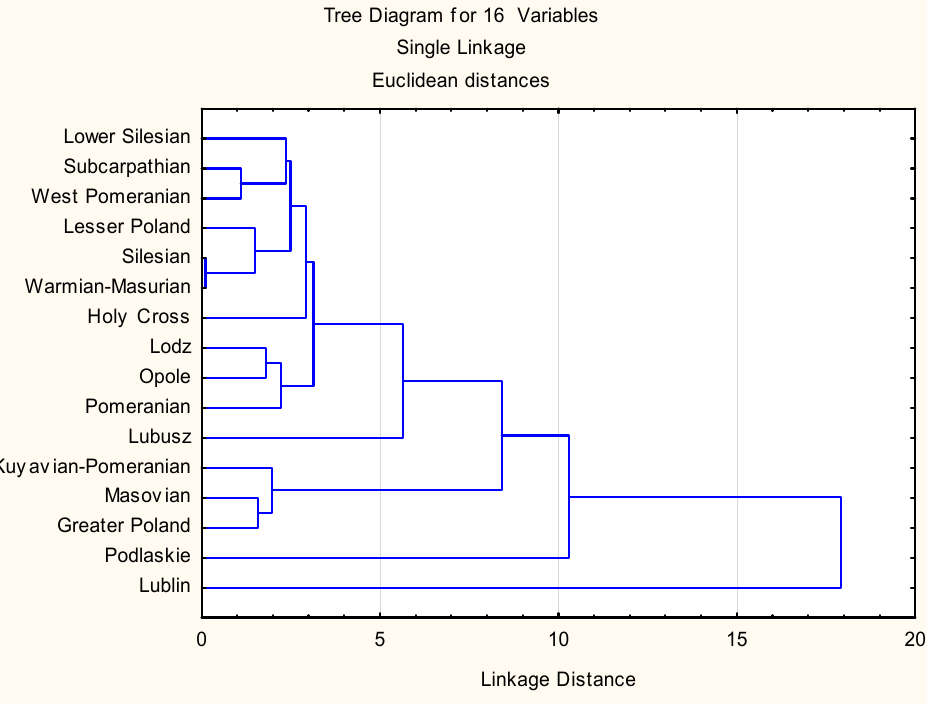
Figure 5. Dendrogram of crop and livestock residues energy potential distribution (2018). Six clusters emerged. The total agricultural residues have the energy potential of 273.23 PJ (Table 2) and they can generate up to 26.60 TWh or 15.65% of the national elec- tricity production. Lublin voivodship maintains a leading position. Table 2. Energy potential by clusters (crop residues and manure biogas), PJ (2018).